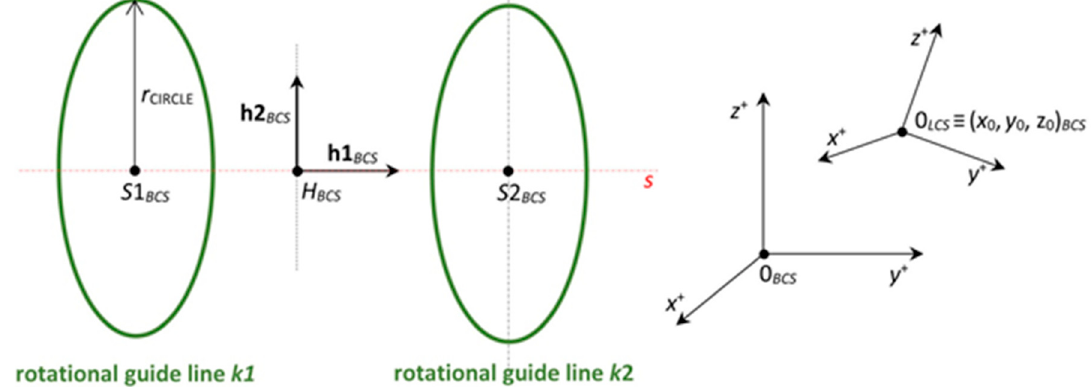
Figure 7. Fiber-processing head in mathematical model in BCS ( left ) and coordinate systems BCS and LCS ( right